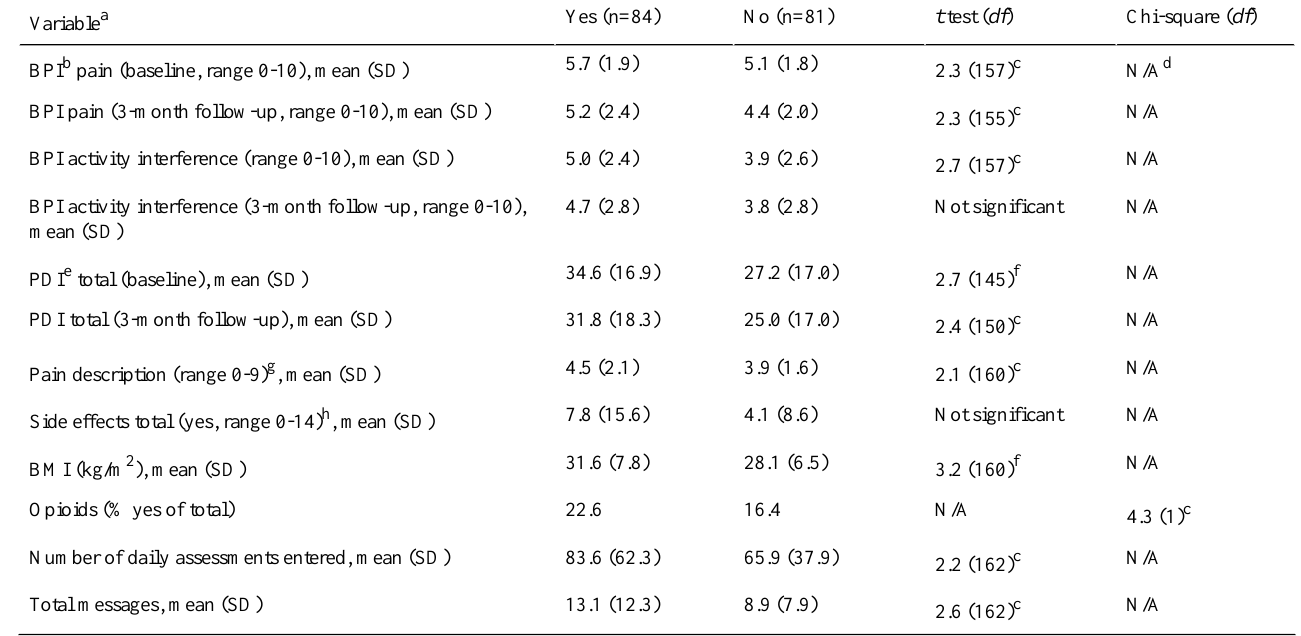
Table 3. Differences between patients with pain who felt that the pain app helped them cope with their pain and were willing to use the app in the future (n=84) and those who reported that the pain app did not help them cope and were less inclined to use it in the future